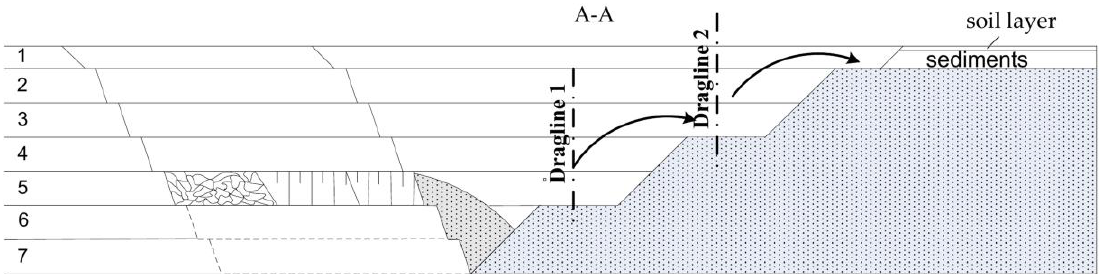
Figure 3. The longitudinal profile of the open pit working area development order.